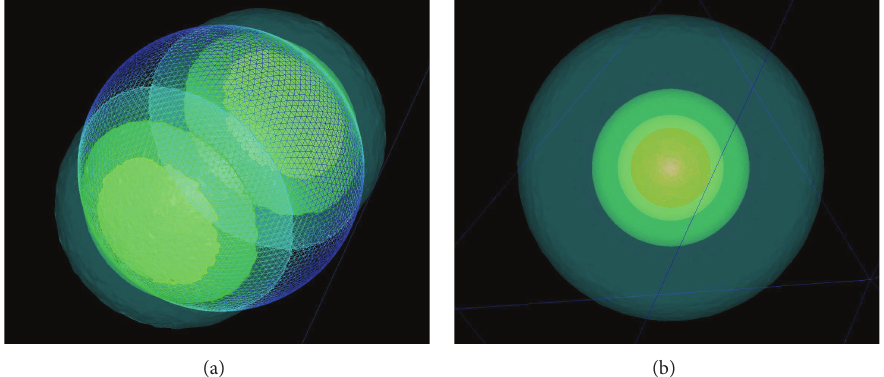
Figure 10: Isosurfaces of the intensity of electric field (a) and temperature (b), after adaptive remeshing with 𝐴 2 strategy ( 𝑁 6 = 1097 595